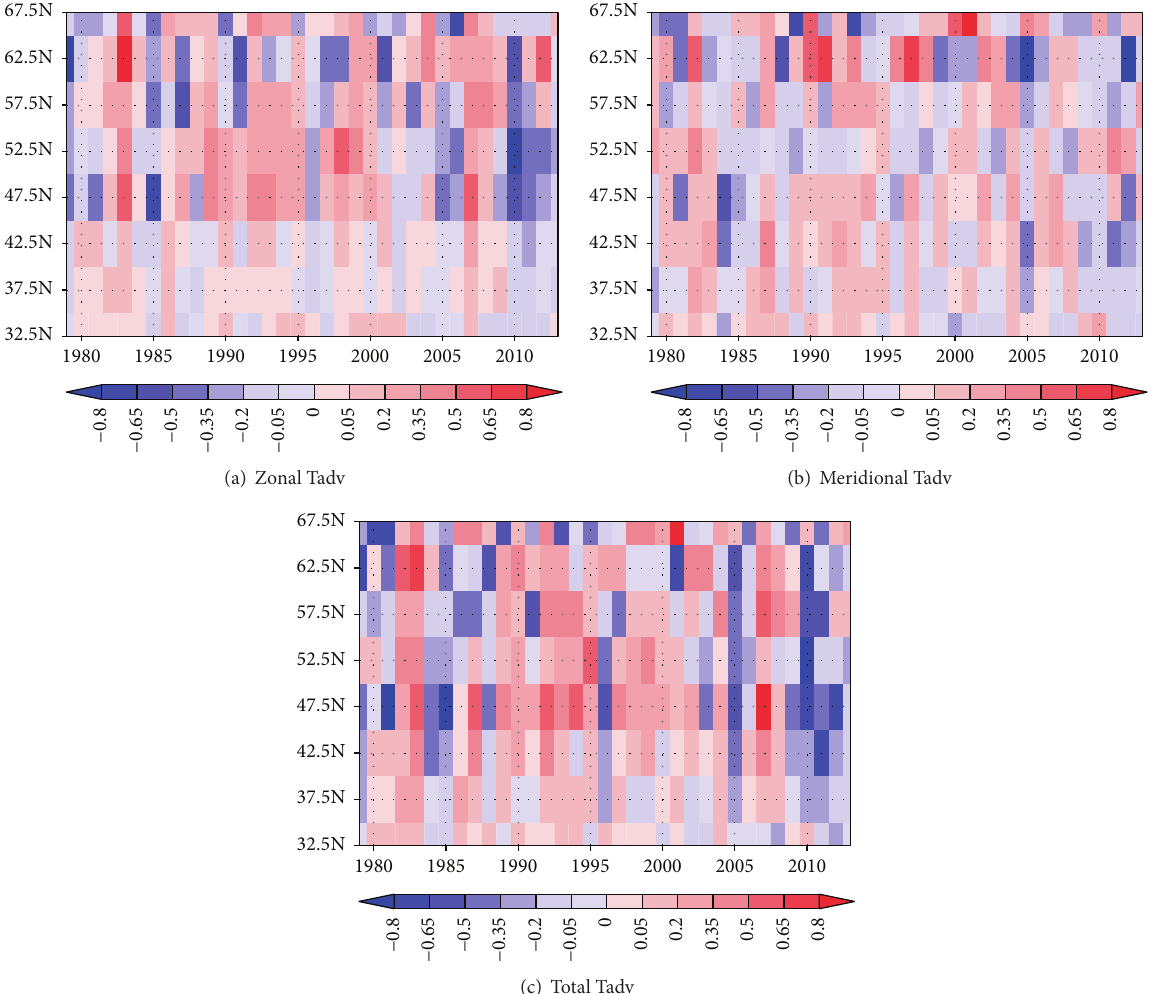
Figure 5: Changing zonal mean zonal ((a), unit: K ∗ day −1 ), meridional ((b), unit: K ∗ day −1 ), and total ((c), unit: K ∗ day −1 ) temperature advection anomalies at the 925 hPa level (1979–2013). Values are calculated at each grid point before area averaging and are calculated for 5 ∘ latitude